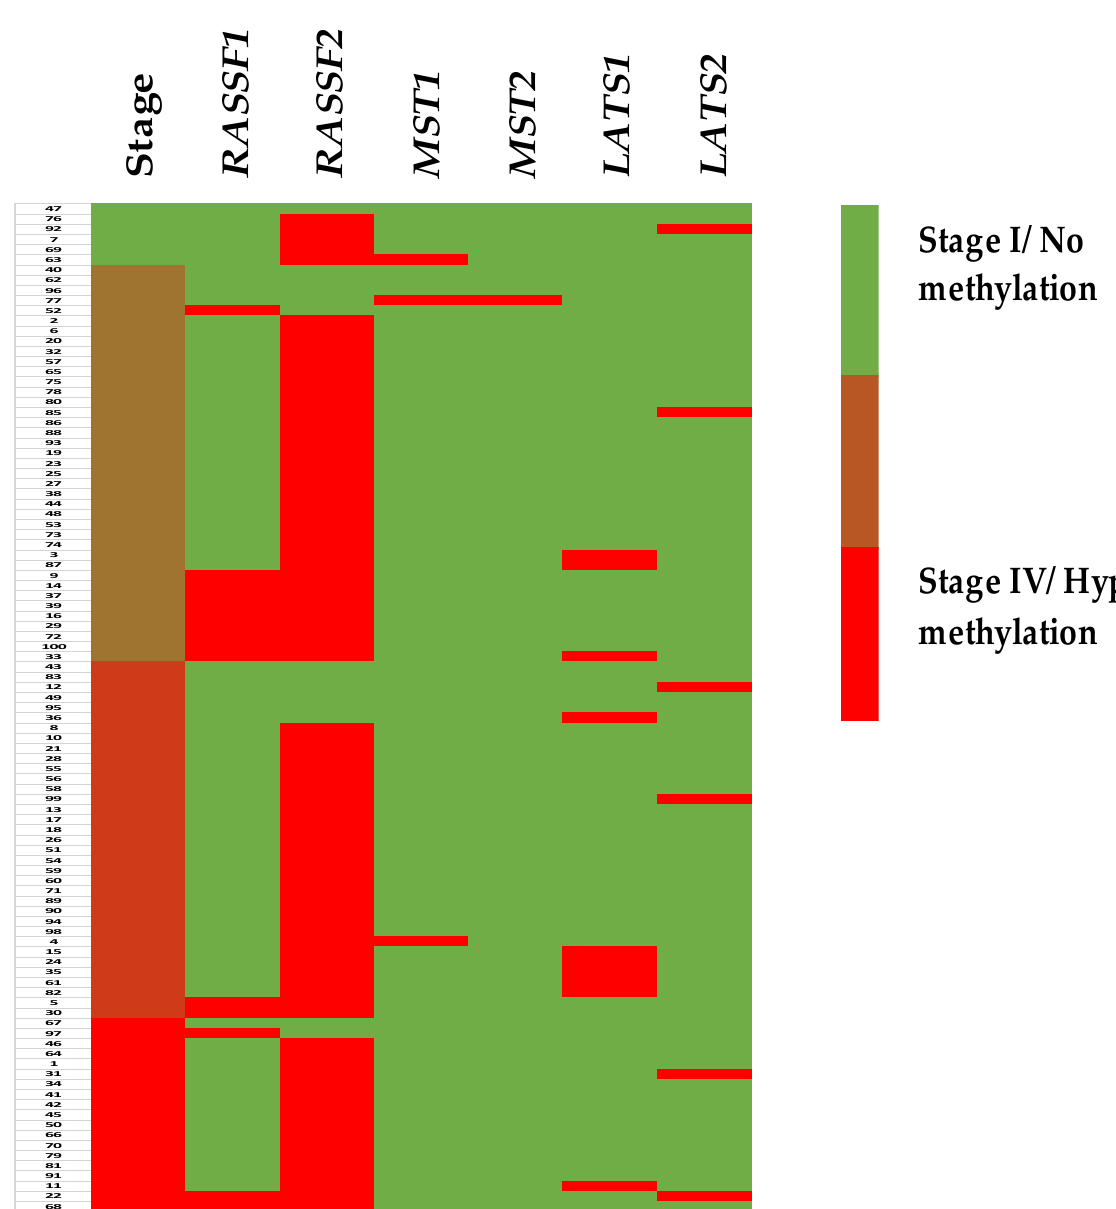
Figure 1. Heat map of RASSF/Hippo signaling pathway data decryption by staging.